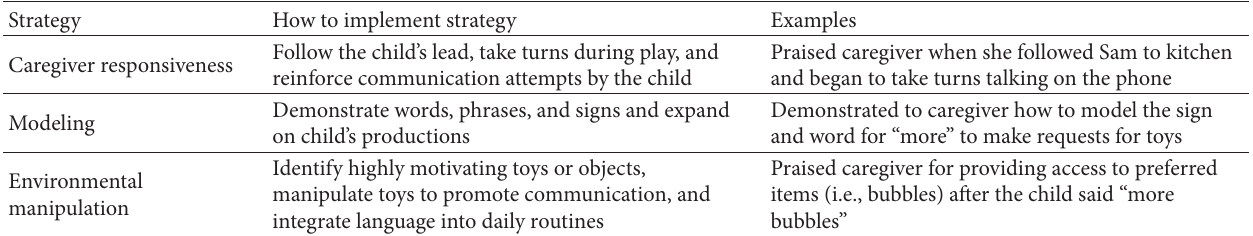
Table 2: Strategies clinicians promoted with